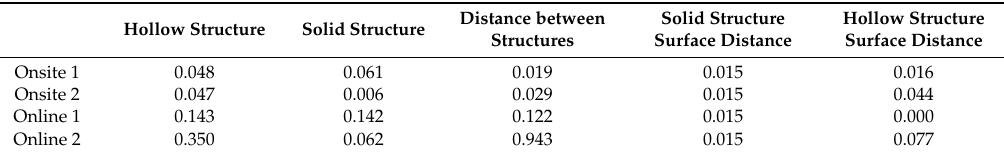
Table 3. ICC for each group and